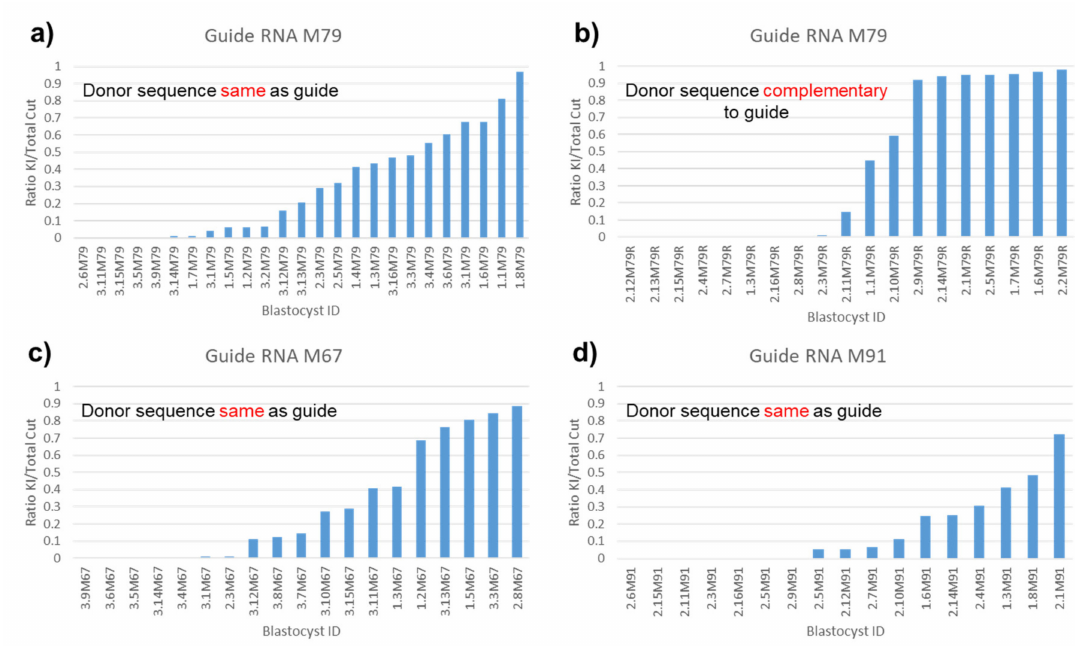
Figure 5. Same-sense donor sequence integrates randomly while complementary donor sequence integrates in a more all-or-none fashion, and silent mutations eliminate the strong distance bias. Data from experiments with Magi1 guide RNA M79, M67, and M91 and paired donor DNA treated blastocysts were bar graphed to study donor integration. For each guide / donor pair, data from two or three separate experiments were combined. Each bar shows the ratio of desired point mutation KIs per total cut genomic DNA for a single blastocyst. Bars are ordered from those with the lowest ratio of desired KI mutation per total cut to those with the highest ratio. ( a ) Blastocysts treated with guide RNA M79 and same-sense donor DNA. Desired mutation is 18 bp from cut. ( b ) Blastocysts treated with guide RNA M79 and complementary donor DNA. As with the same-sense, the desired mutation is 18 bp from cut. ( c ) Blastocysts treated with guide RNA M67 and same-sense donor DNA. Desired mutation is 31 bp from cut. ( d ) Blastocysts treated with guide RNA M91 and same-sense donor DNA. Desired mutation is 5 bp from cut. Both same-sense and complementary donors integrate their sequence into roughly half of the blastocysts with cut DNA but the pattern of integration is di ff erent. Those donors which are same-sense to the guide appear to integrate their sequence into a random proportion of the blastocyst’s cells, while the donor sequence that is complementary to the guide appears to be integrated more often into either all of the cells of the blastocyst or none of them. Furthermore, silent mutations eliminated the strong distance bias, possibly by preventing homologous recombination in the nonidentical region, forcing recombination to occur beyond